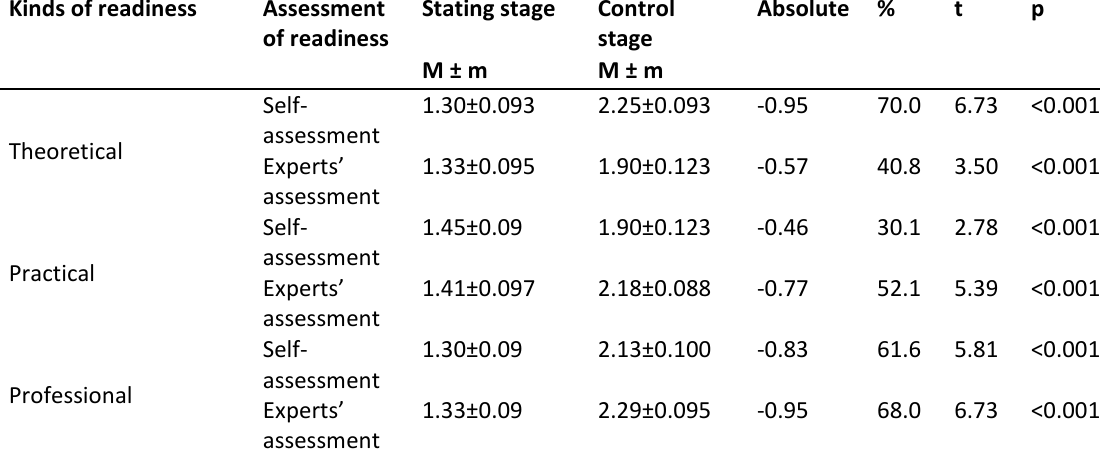
Table 4. Students’ readiness to apply self-regulation means (points) Kinds of